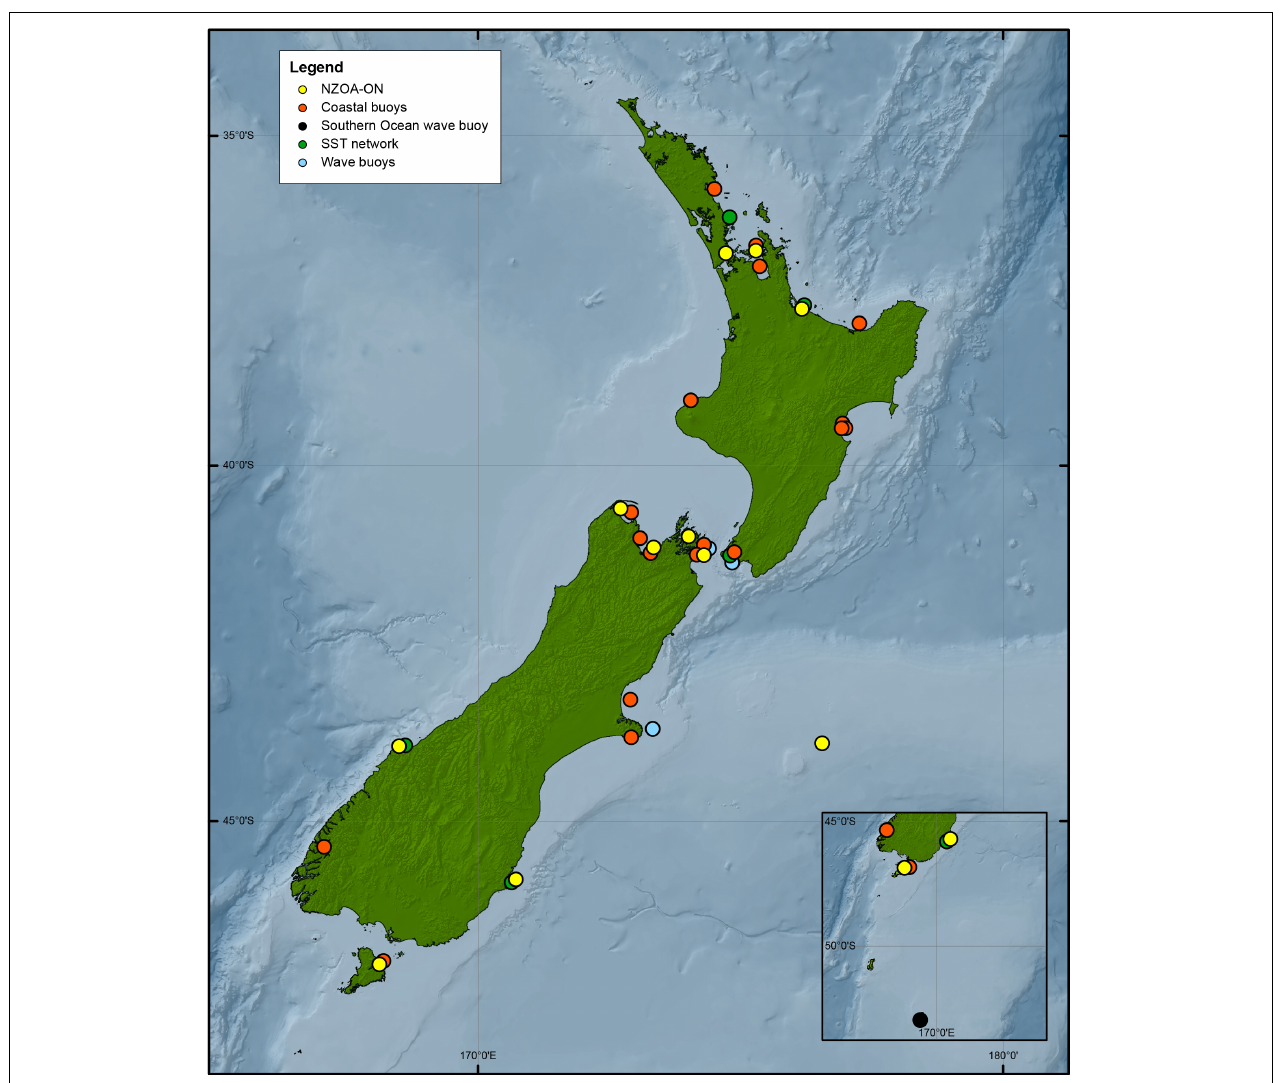
FIGURE 1 | Map of New Zealand (NZ) with observational assets are overlaid on the bathymetry. Assets shown are wave buoys (blue dots), coastal buoys (orange dots), NZOA-ON (yellow dots), SST network (green dots) and the Southern Ocean wave buoy (black